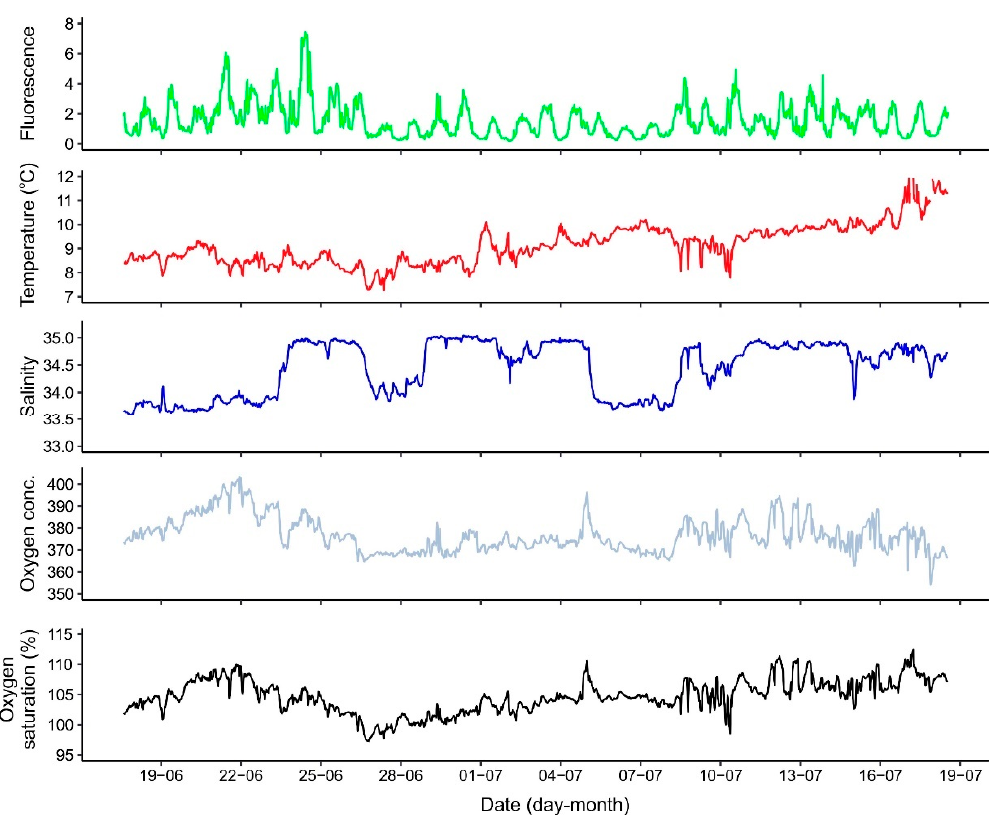
Figure 5. Subset of environmental variables (fluorescence, temperature, salinity, and oxygen) recorded by the Wave Glider during a 1-month period (June–July 2018) across a transect in the LoVe region.